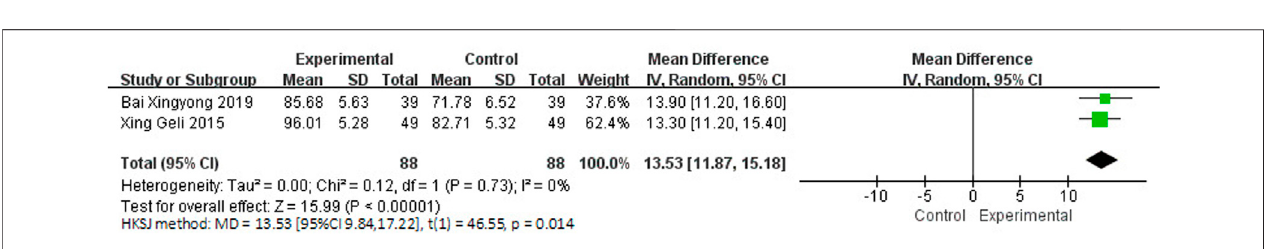
FIGURE 7 | Meta-analysis of BI by NBP as